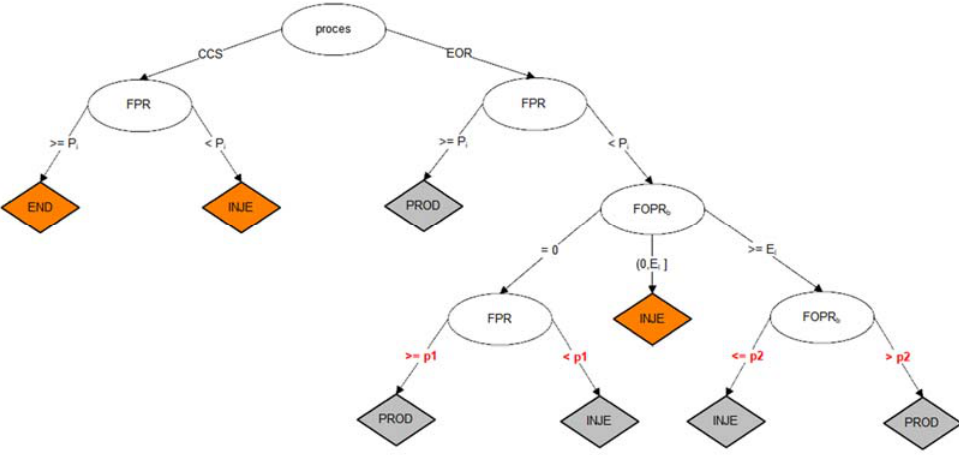
Figure 6. Parameterized decision tree developed for the CCS-EOR process.